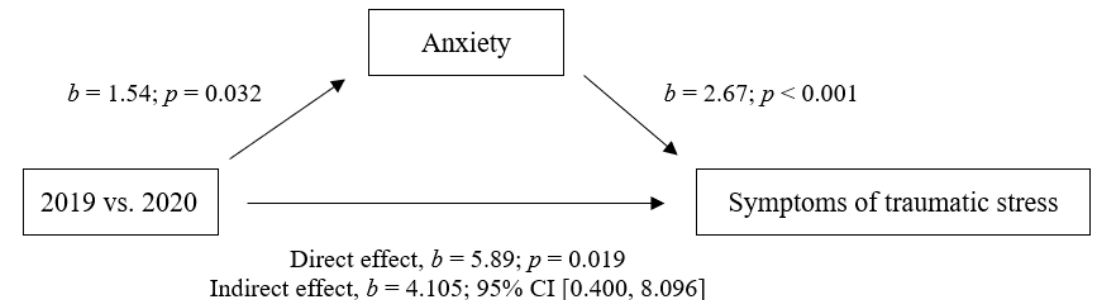
Figure 1. Model of group variable (2019 vs. 2020) as a predictor of traumatic symptoms (IES-R), mediated by anxiety (HADS-Anx). A BCa bootstrapped CI based on 5000 samples was used to measure the confidence interval for the indirect effect.